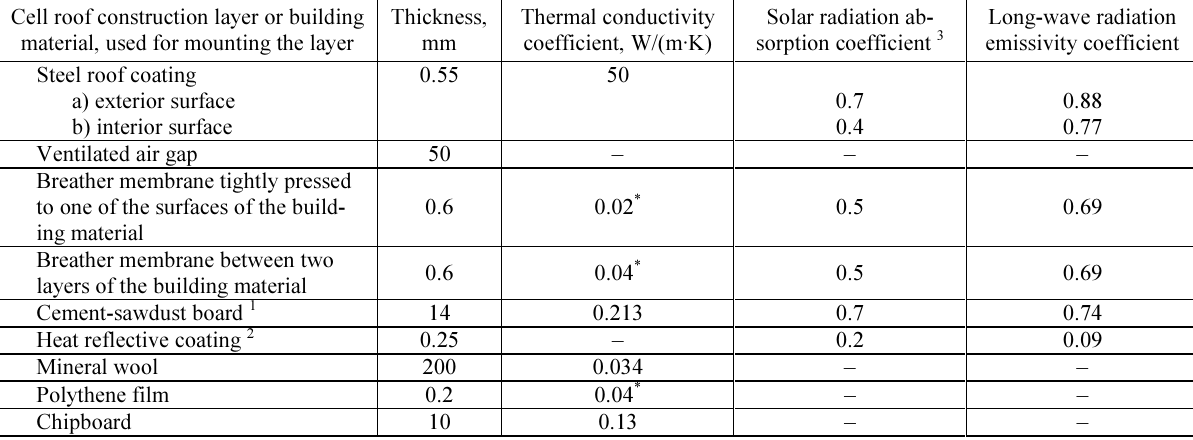
Table 1. Values of thermal technical indicators of the cell roof construction layers and building materials, used for mounting the layers Cell roof construction layer or building material, used for mounting the layer